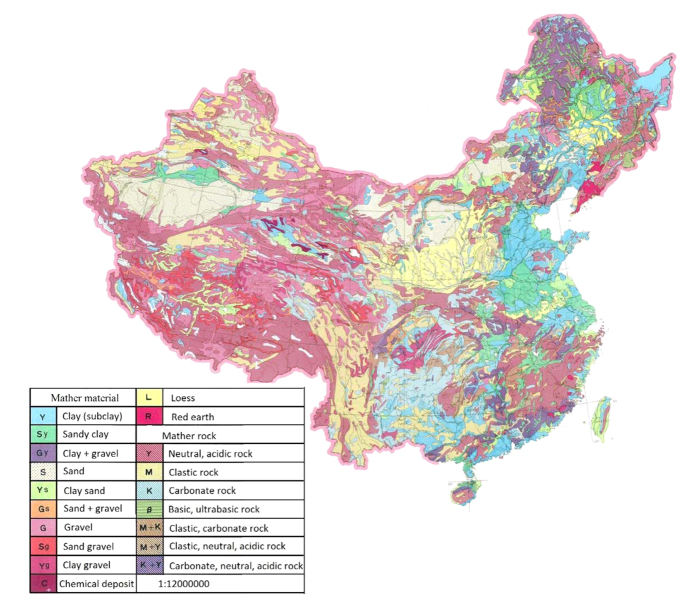
Map of soil parent material and rock of China from a book titled “The atlas of soil environmental background value in the People’s Republic of China”. 1994, page 10–11, China Environmental Science Press. The maps were modified using Arc GIS Geographic Information Systems software version 10.2 (Environmental Systems Research Institute Inc, Redlands, Calif).